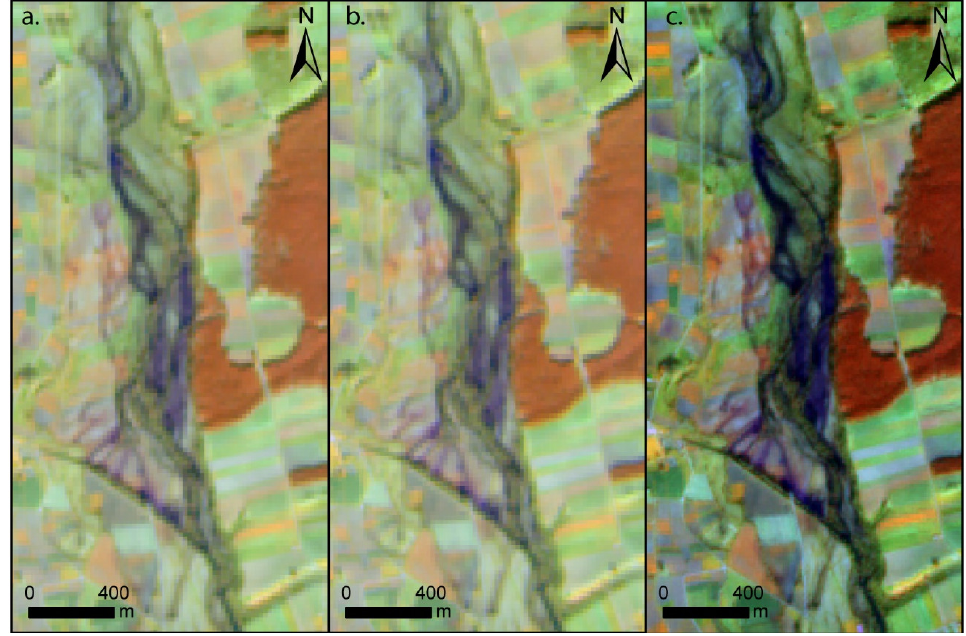
Figure 3. Sentinel-2 images using composite bands: ( a ) Raw image. ( b ) Resampled image. ( c ) Super- resolution image.